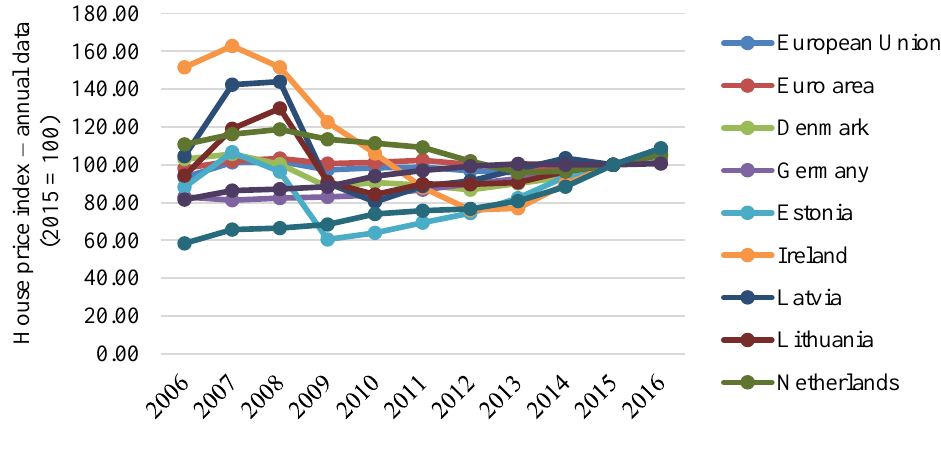
Fig. 1. House price index, 2015 = 100. Data: Eurostat (n.d.). (Figure made by authors)